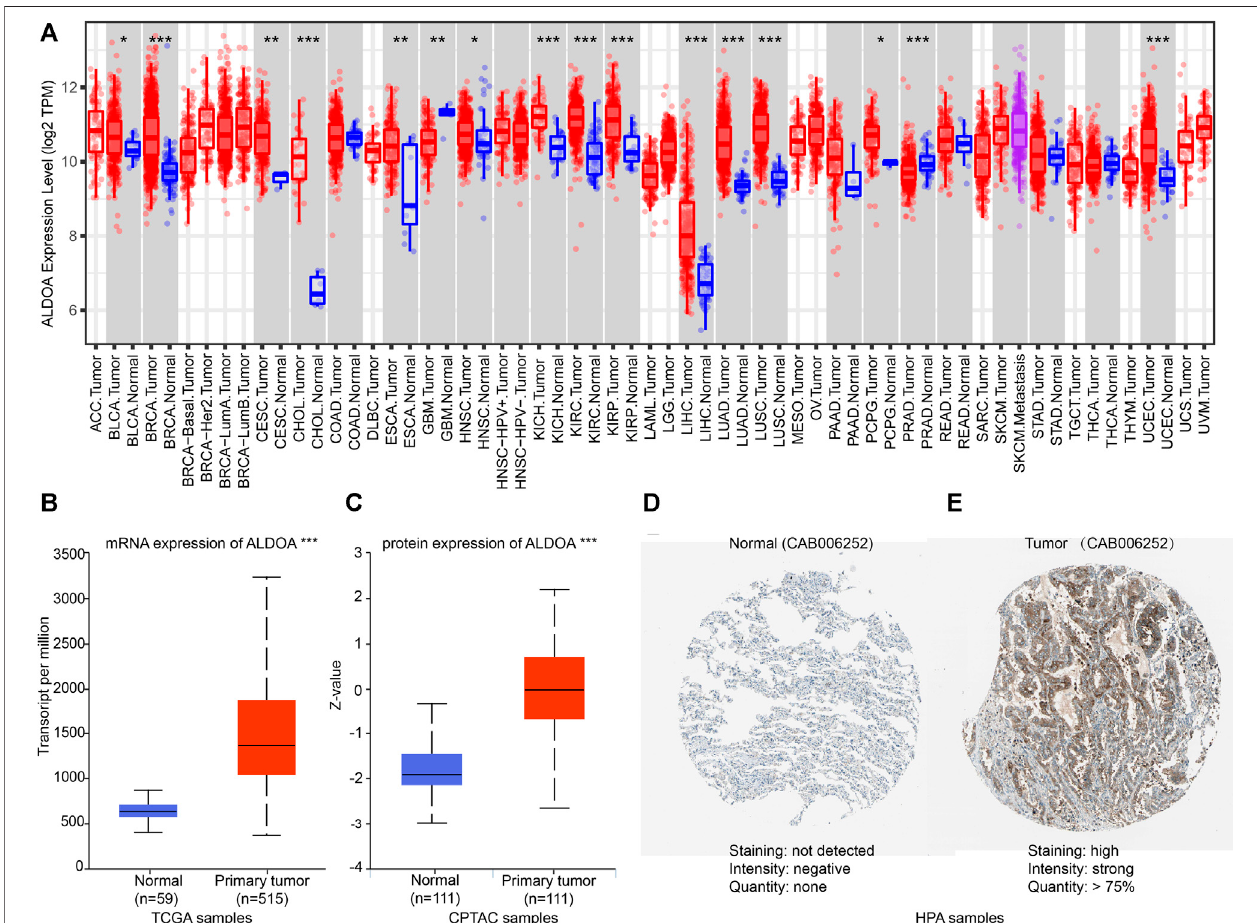
FIGURE 2 | Expression of ALDOA from TCGA, CPTAC, and HPA (A) ALDOA was upregulated in 14 cancer types, including BLCA, BRCA, CESC, CHOL, ESCA, HNSC, KICH, KIRC, KIRP, LIHC, LUAD, LUSC, PCPG, and UCEC. ALDOA was downregulated in GBM and PRAD (B) The mRNA expression of ALDOA in 59 normal tissues and 515 lung adenocarcinoma tissues (C) The protein expression of ALDOA in 111 lung normal tissues and 111 lung adenocarcinoma tissues (D) The protein expression of ALDOA in normal tissue. Staining was not detected, intensity was negative, and quantity was none (E) The protein expression of ALDOA in lung adenocarcinoma tissue. Staining was high, intensity was strong, and quantity > 75%. HPA normal: https://www.proteinatlas.org/ENSG00000149925-ALDOA/tissue/ lung#img,HPA tumor: https://www.proteinatlas.org/ENSG00000149925-ALDOA/pathology/lung+cancer#img (*, p < 0.05; **, p < 0.01, ***, p <